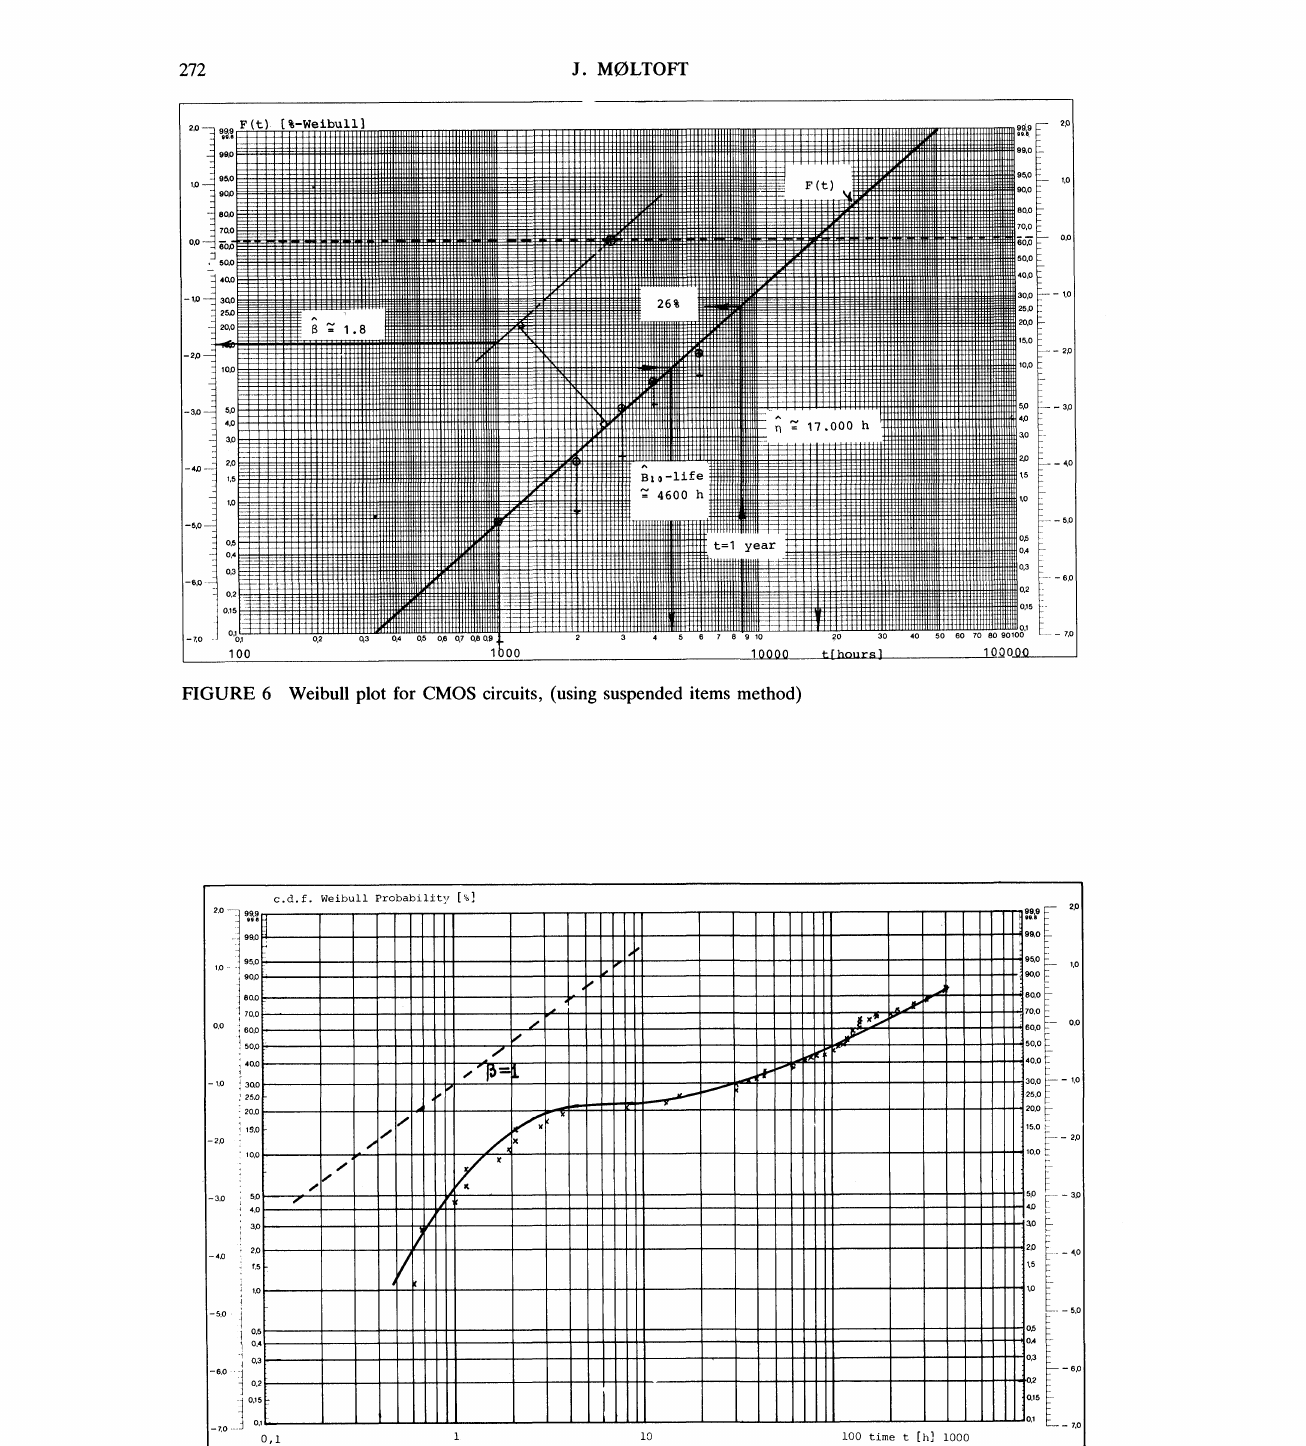
FIGURE 7 The cumulative failure distribution function for CMOS type 4007 tested at a temperature of